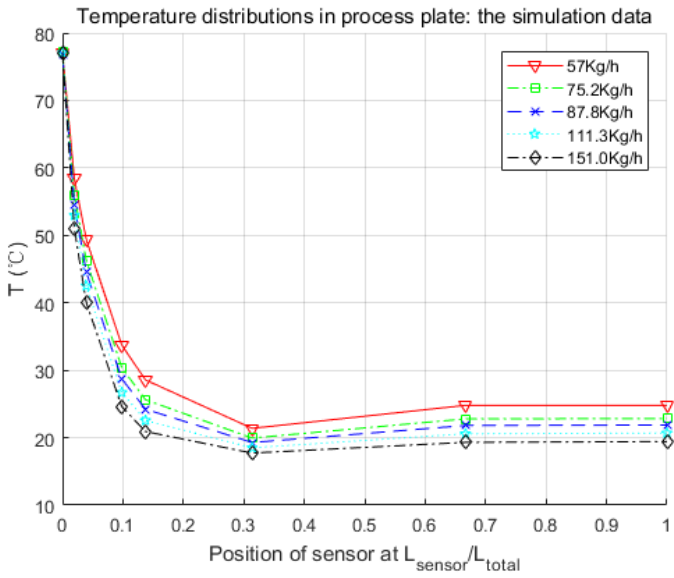
Figure 10. Simulation results of the process fluid temperature along the process channel for different utility flow rates, with M p = 10 kg · h − 1 and T p − in = 77 ◦